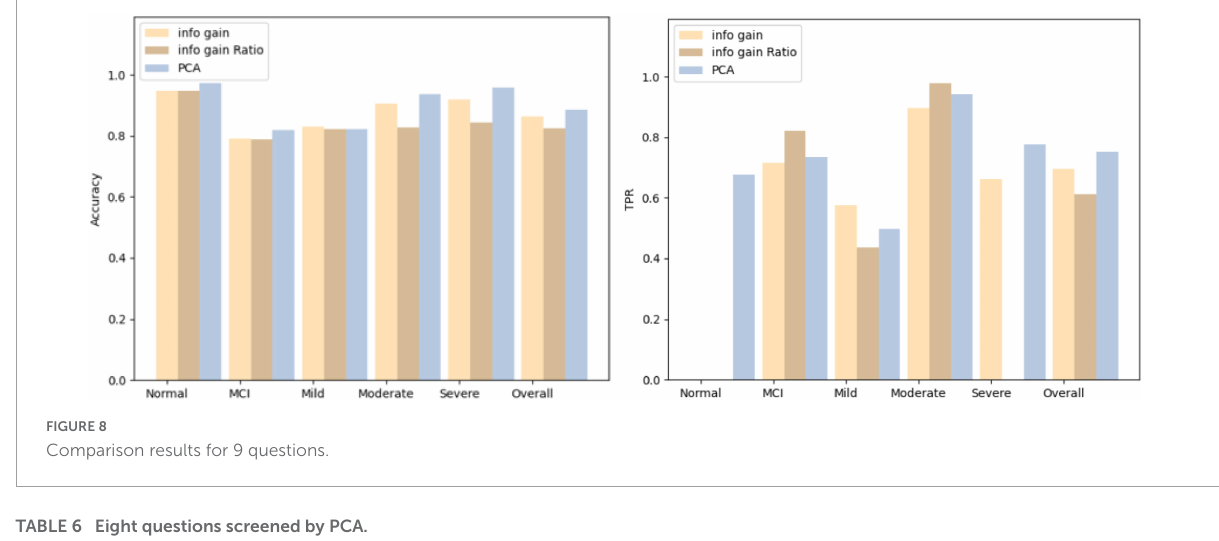
TABLE 6 Eight questions screened by PCA.